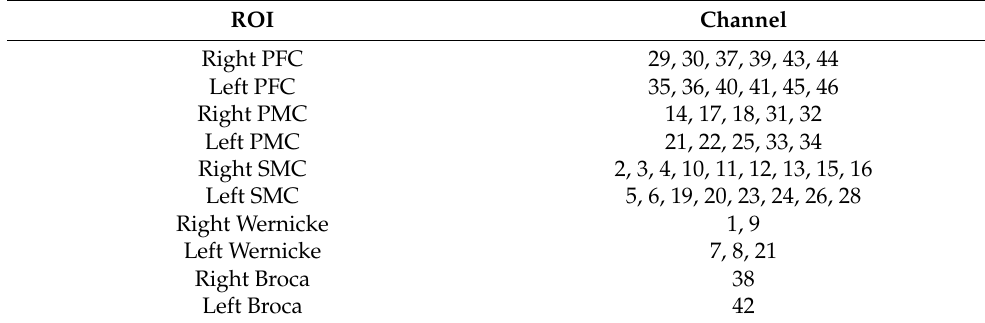
Table 2. The characteristics of all participants.